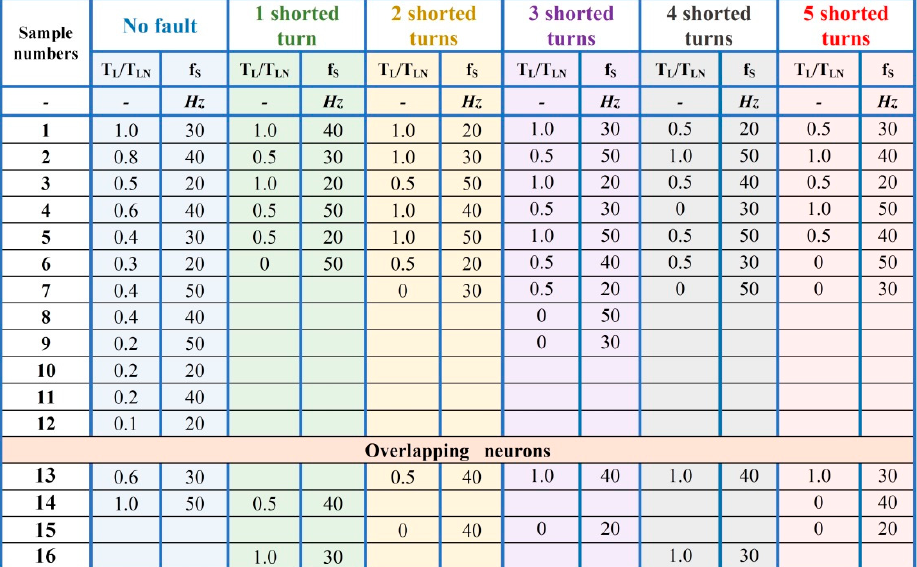
Figure 14. Specification of the test data parameters for the classification of the stator winding faults with 10 × 10 SOM; T L —load torque, T LN —rated motor torque, f s —frequency of the supply voltage.